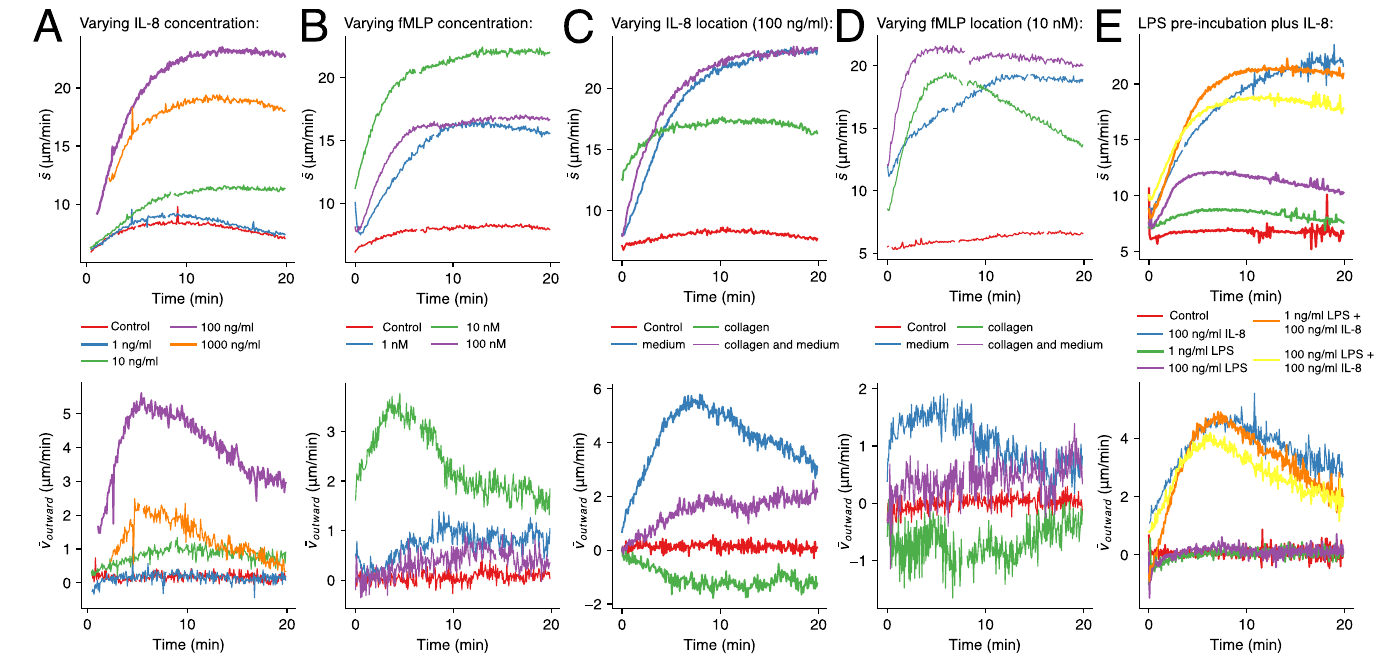
Fig 4. Results of chemotaxis experiments. (A) Average undirected speed (top) and average outward velocity (bottom) of neutrophils subjected to concentrations of 0, 1, 10, 100, and 1000 ng/ml IL-8 in the surrounding medium. (B) Same as (A) but for 0, 1, 10, and 100 nM fMLP. (C) Average undirected speed and average outward velocity of neutrophils subjected to a concentration of 100 ng/ml IL-8 in the surrounding medium (blue), in the hydrogel (green), in both (purple), without IL-8 (red). (D) Similar to (C) but with 10 nM fMLP. (E) Migration behavior of neutrophils is altered by incubation with LPS. Comparison of six conditions: low dose (1 ng/ml) and high dose (100 ng/ml) LPS, each with and without 100 ng/ml IL-8, control. Each graph in every figure displays the weighted average of three independent